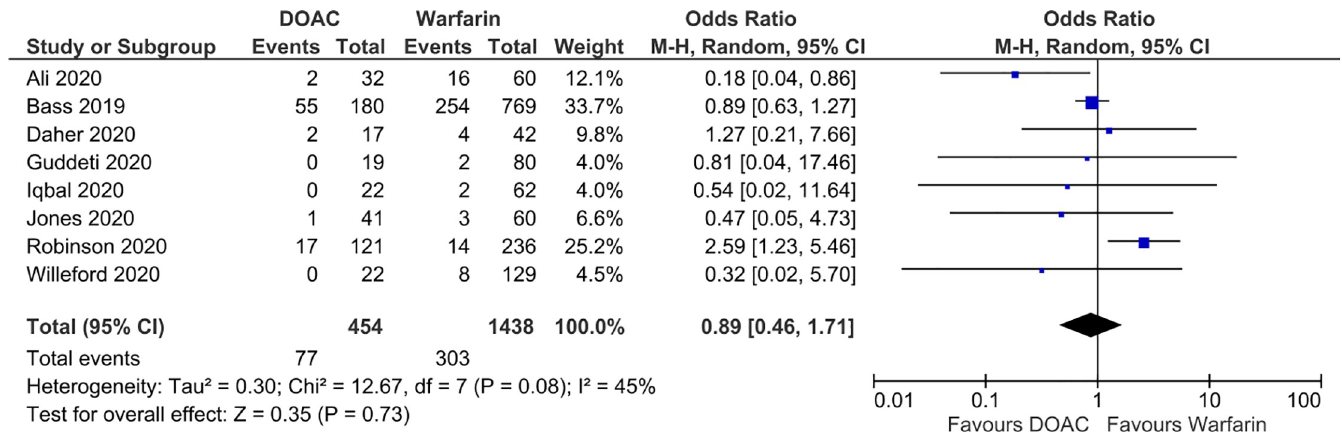
Fig 2. Forest plot of stroke of systemic embolism event rate in patients with left ventricular thrombus receiving DOACs versus VKA.